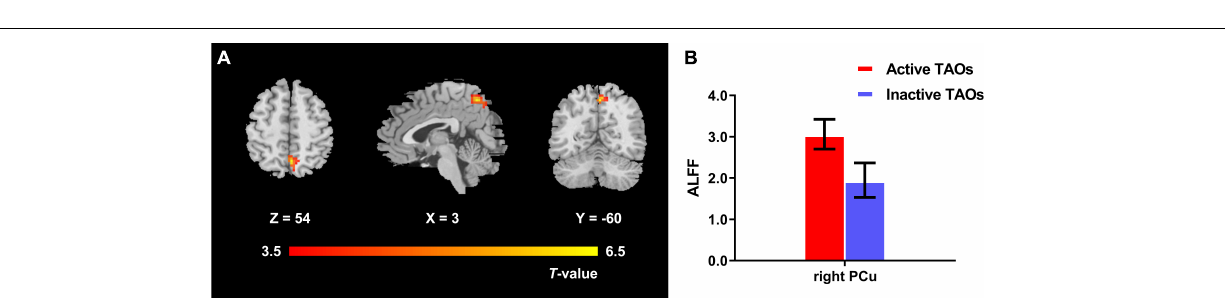
FIGURE 2 | (A) Brain regions with significant ALFF difference between active TAO group and HCs. Compared with HCs, active TAO group showed significantly decreased ALFF values in the left middle occipital gyrus, superior occipital gyrus, and cuneus (voxel P < 0.001, cluster P < 0.05, cluster-level FWE corrected, cluster size ≥ 48 voxels). Cold color denotes relatively lower ALFF values in the active TAO group, and the color bar indicates the T value from the two-sample t -test between the active TAO group and HCs. (B) The bar plot demonstrates the ALFF difference of significant brain regions in active TAO group and HCs. The ALFF values used were the mean ALFF values extracted by using an ROI defined as a sphere centered at the peak voxel with a 6-mm radius. ALFF, amplitude of low frequency fluctuation; TAO, thyroid-associated ophthalmopathy; HCs, healthy controls; FWE, familywise error; ROI, region of interest; MOG, middle occipital gyrus.